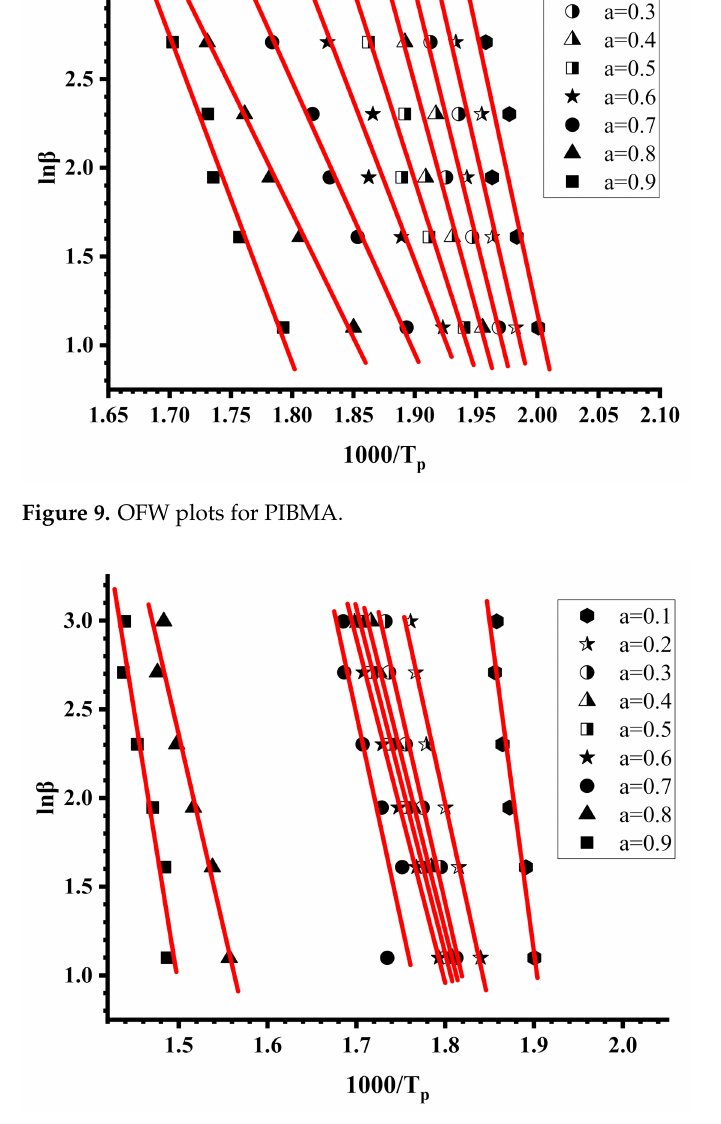
Figure 10. OFW plots for sample R20-80. Table 7. Activation energies Ea (KJ/mol) by the Kissinger